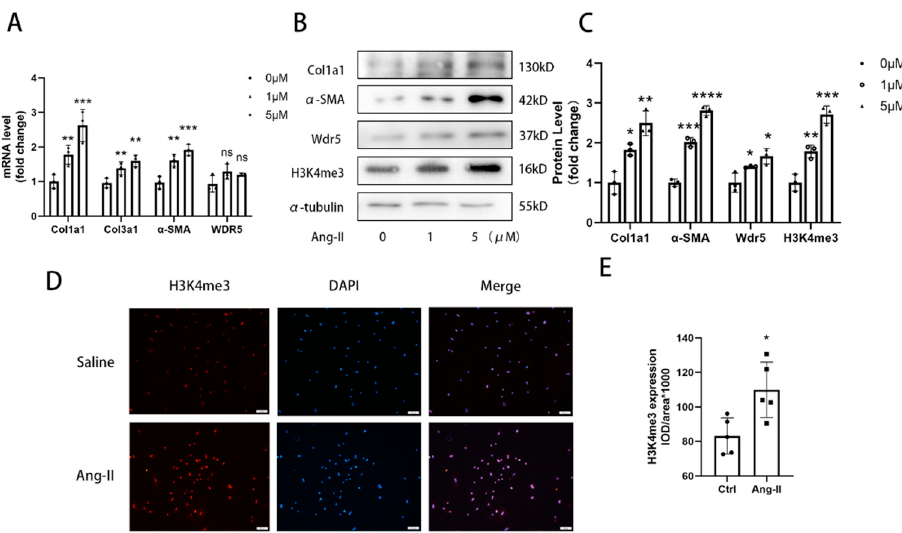
Figure 2. Wdr5 is upregulated in Ang-II-stimulated NRCFs. ( A ) Col1a1, Col3a1, and α -SMA mRNA levels were upregulated after Ang II stimulation. ( B ) Col1a1, α -SMA, Wdr5, and H3K4me3 protein levels were upregulated in respond to Ang II. ( C ) is the quantitative statistic of ( B ) graph. ( D ) Immunofluorescence data of H3K4me3 in NRCFs (Scale bar 100 µm). ( E ) is the quantitative statistic of ( D ) graph. Data are presented as mean ± SEM. * p < 0.05, ** p < 0.01, *** p < 0.001, **** p < 0.0001 vs. saline.